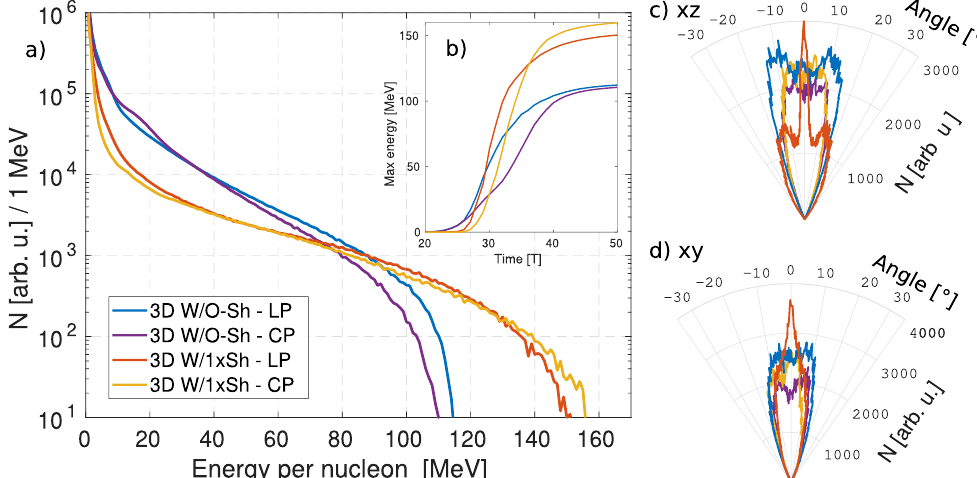
Figure 11. Properties of silver ions from the 3D simulations with the plasma shutter (W/1xSh) and without (W/O-sh) for linear (LP) and circular (CP) polarization. ( a ) Energy spectra at the end of the simulation ( t = 70 T ), ( b ) time evolution of the maximal energy. Angular distributions of ions with energy over 55 MeV per nucleon in the x - z plane ( c ) and x - y plane ( d ). Source: [79]. Figures reprinted under the terms of the Creative Commons Attribution